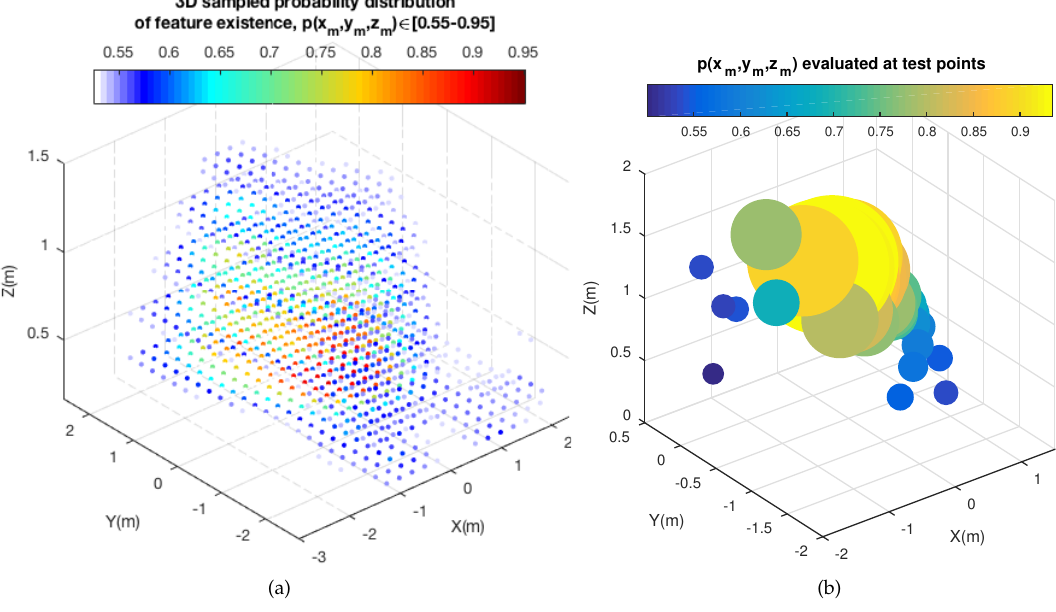
Figure 7. 3D sampled probability distribution of feature existence. ( a ) Complete 3D sampled probability distribution, p ( x m , y m , z m ) ; ( b ) p ( x m , y m , z m ) evaluated at the last feature points observed (test